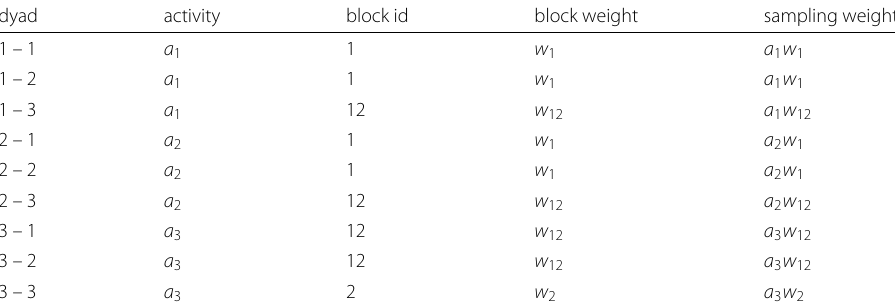
Table 2 Edge list with weights for the generation of synthetic graphs with given vertex activities and block structure